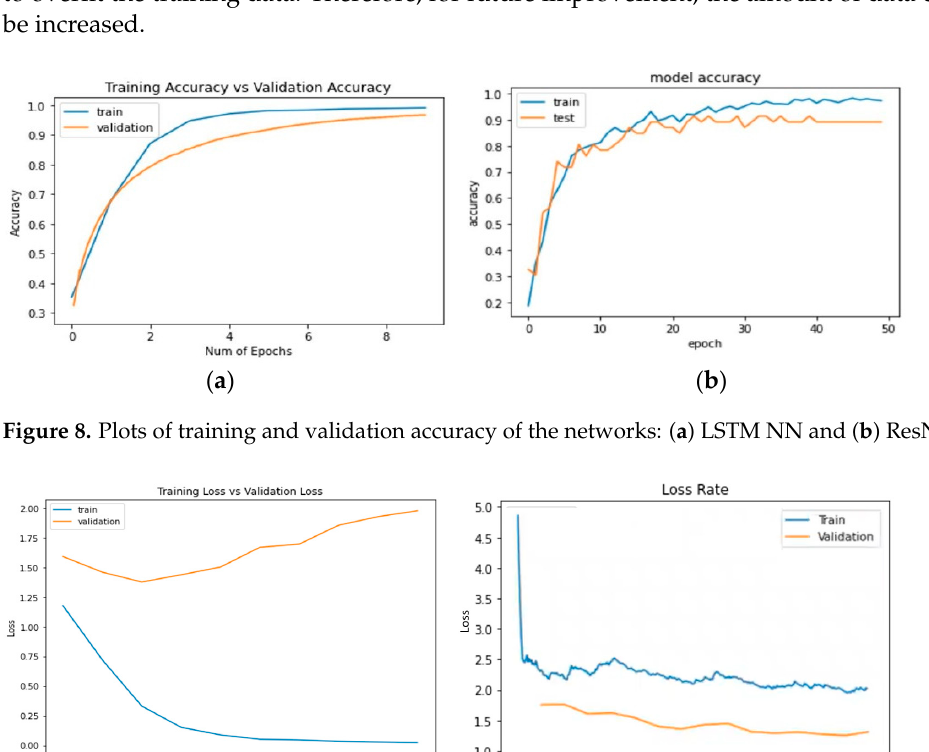
Figure 9. Plots of training and validation loss of the networks: ( a ) LSTM NN and ( b ) ResNet34.